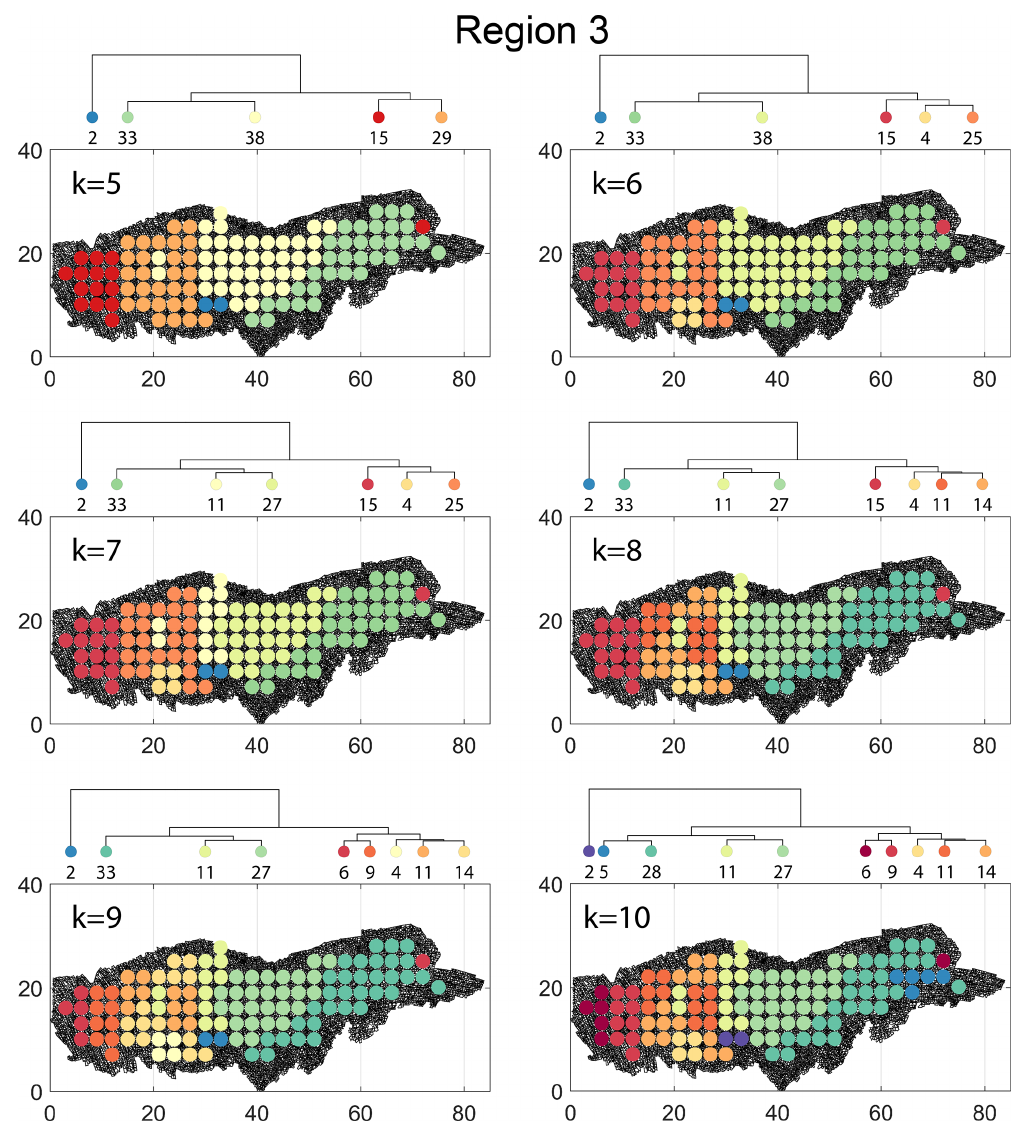
Figure B9. Variation in cluster boundaries for “ k ” clusters in Region 3 using fingerprint distance.